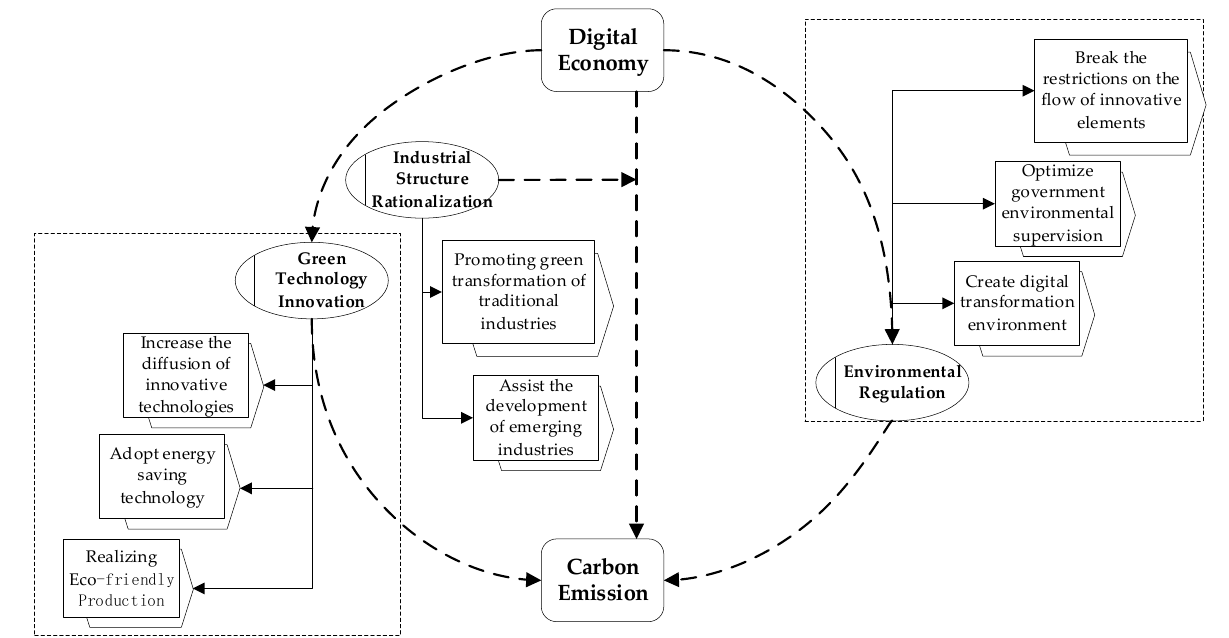
Figure 1. Theoretical framework diagram of the digital economy affecting carbon emissions.